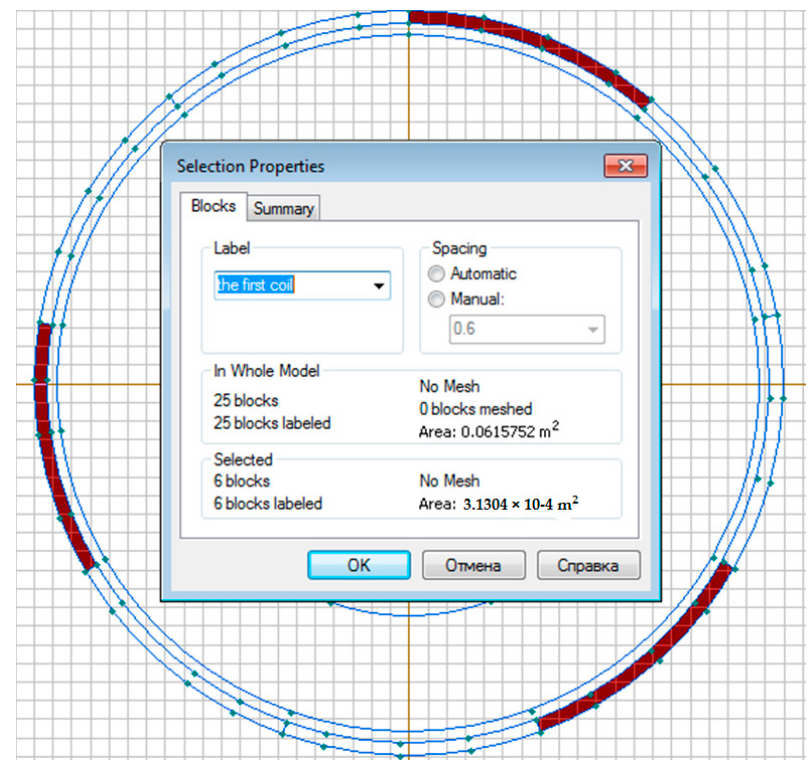
Figure 8. The property of the label “the first coil.”